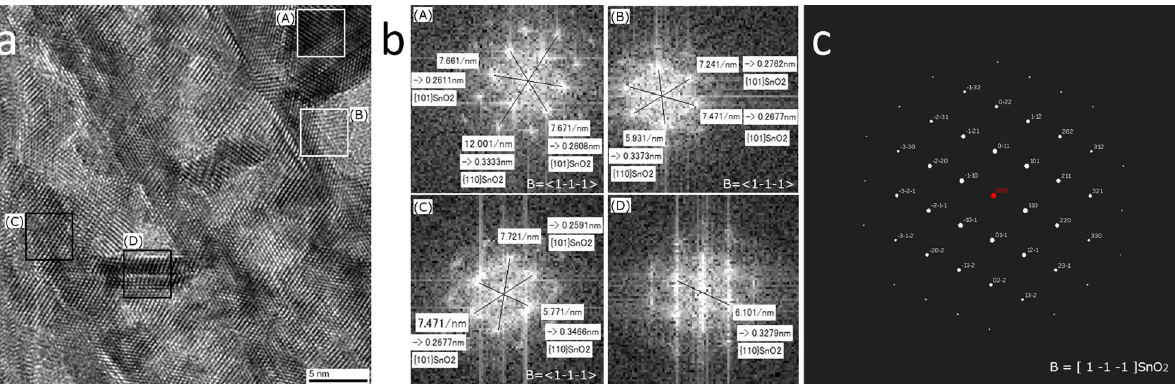
Figure 5. ( a ) High-resolution plane-observed TEM image of the SnO 2 nanosheets connected with a branch angle of 90° (square A and B) or 40°–50° (square C and D). ( b ) FFT images of A, B, C, or D calculated from the TEM images in square A, B, C, or D, respectively. ( c ) Calculation of selected area electron diffraction (SAED) pattern from the direction of B = < 1 − 1 − 1 > of SnO 2